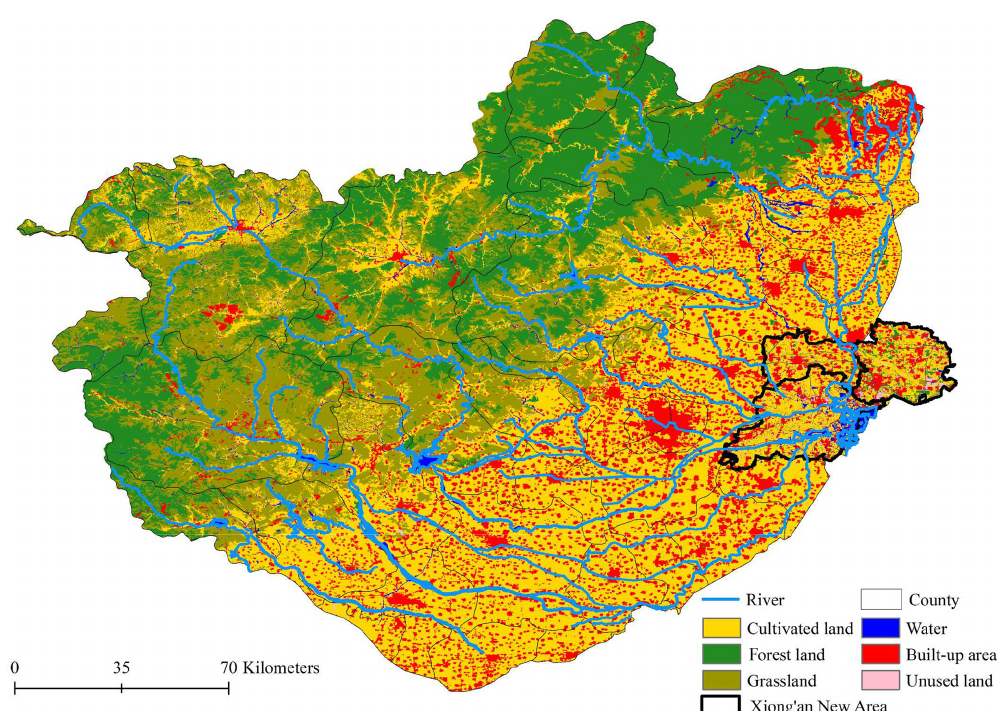
Figure 4. Map of the Baiyangdian River basin and the Xiong’an New Area (marked with solid black lines).